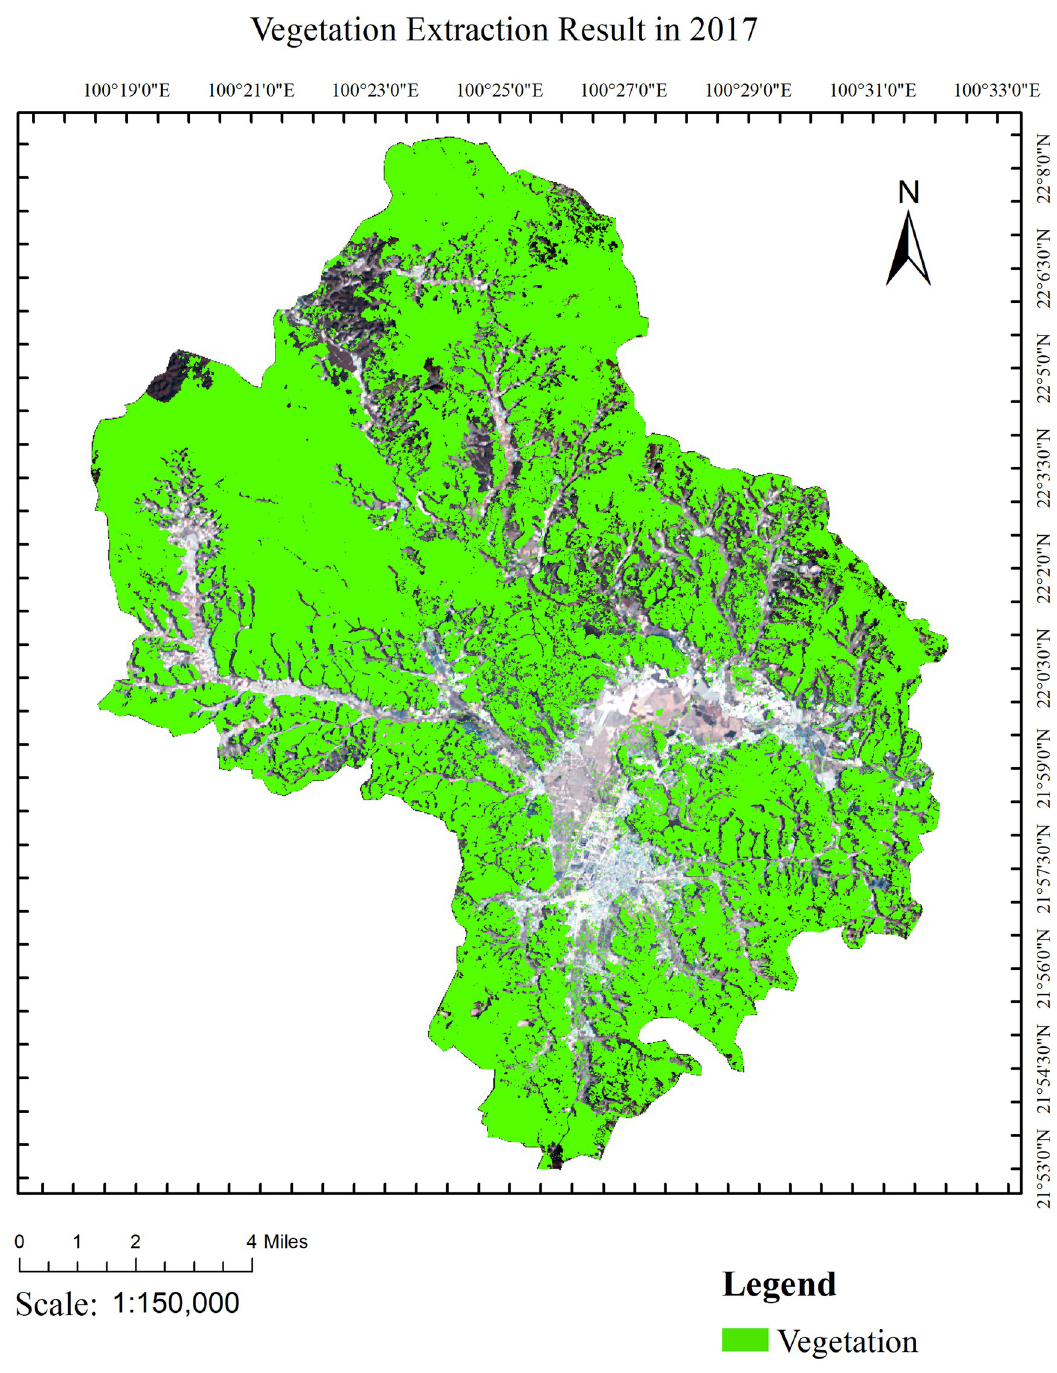
Fig 4. 2017 Vegetation extraction results. The base map of the LandSat8 OLI images with the following composition:R (4),G (3) and B (2). The LandSat8 OLI images were downloaded from USGS National Map Viewer.